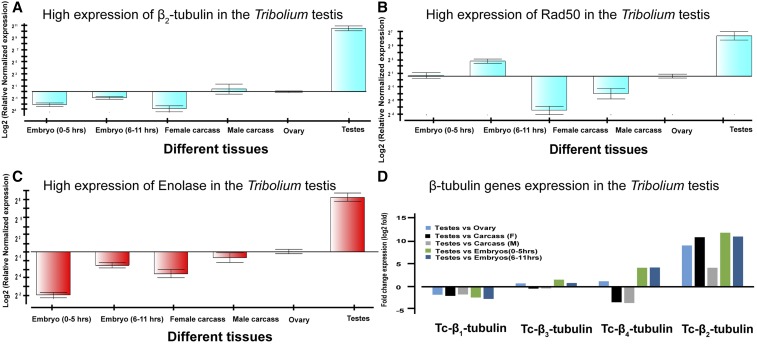
Quantitative real time PCR based validation of highly expressed genes in the testes. Normalized expression of β2-tubulin (A), Rad50 (B) and Enolase (C) was determined in testis tissue compared to ovary, male carcass, female carcass, embryo (0-5 hr) and embryo (6-11 hr) based on qPCR analysis. Fold change expression of four β-tubulins (Tc-β1, Tc-β2, Tc-β3 and Tc-β4 tubulin) in testis compared to ovary, male carcass, female carcass, embryo (0-5 hr) and embryo (6-11 hr) based on RNA seq analysis (D).